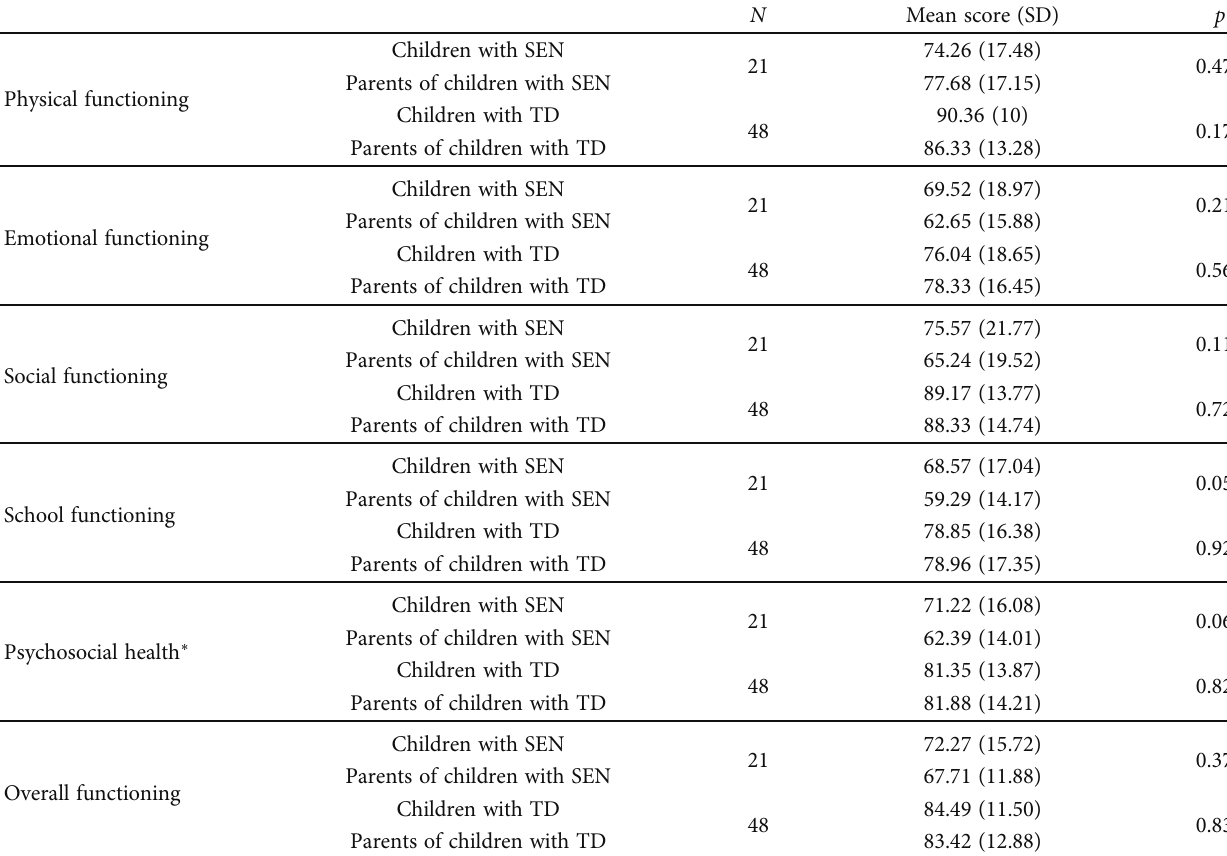
Table 7: Parent – child agreement on